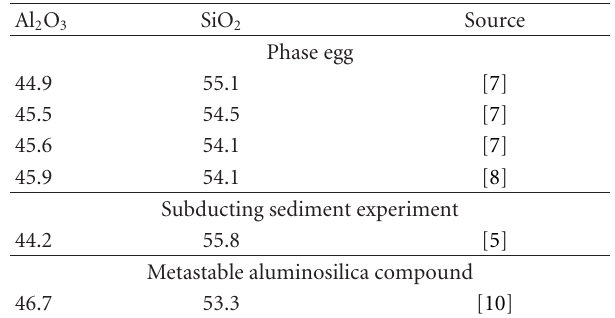
Table 1: Composition (oxide wt%) of phase egg (calculated on a water-free basis) obtained in laboratory simulation experiments [7, 8], including a sediment analog that contained minor < 1.5wt%, TiO 2 , FeO, trace amounts ( < 0.52 wt%) of MgO, CaO, Na 2 O, and K 2 O, and 6wt% H 2 O [5], and the vapor-condensed, amorphous, metastable eutectic aluminosilica compound [10].